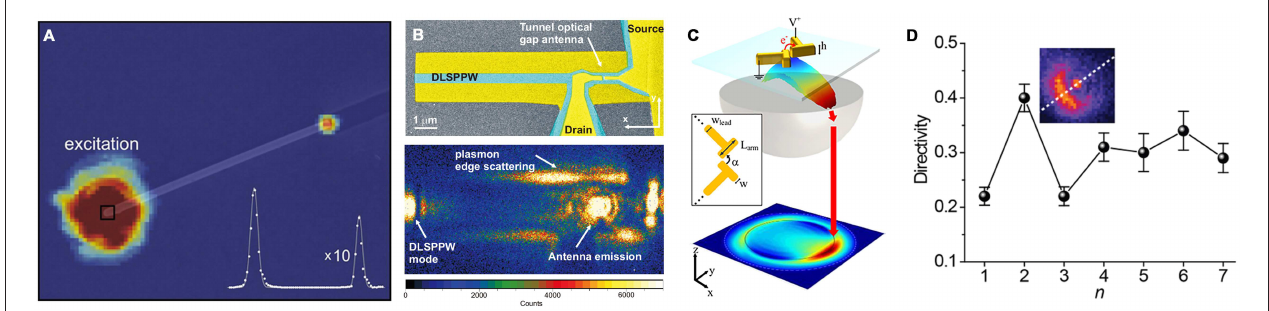
FIGURE 2 | (A) A map of optical emission intensity from an Au nanowire excited by an STM tip. (B) False color SEM image of a tunnel junction on the top of a DLSPPW waveguide, together with an optical intensity map, showing generation of the propagating plasmonic mode at the junction region and its outcoupling to the free-space radiation at the other end of the waveguide. (C) Tunneling-driven highly directional emission from a V-shaped nanoantenna. (D) The dependence of the directivity of the SPP excitation on the structural characteristics of self-assembled S(CH2)nBPh polymer molecules filling the tunneling gap defined by the chain parameter n . The inset shows an experimental measure defocused patterns corresponding to a tunnel junction with n = 2. (A) is reprinted with permission from Ref. [52]. © 2011 American Physical Society. (B) is reprinted with permission from Ref. [53]. Copyright © 2016 Optical Society of America. (C) is reprinted with permission from Ref. [54]. Copyright © 2017 American Chemical Society. (D) is reprinted with permission from Ref. [55]. Copyright © 2019 American Chemical Society.